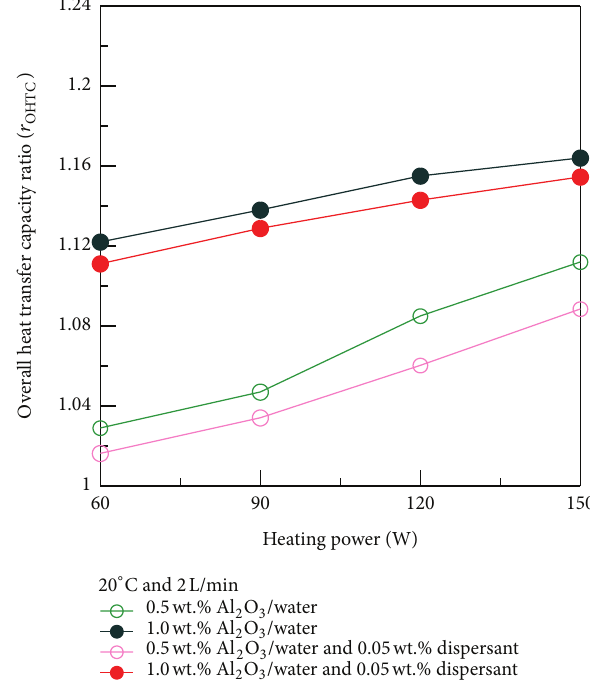
Figure 6: Increment of overall heat transfer capacity (20 ∘ C and 1L/min).